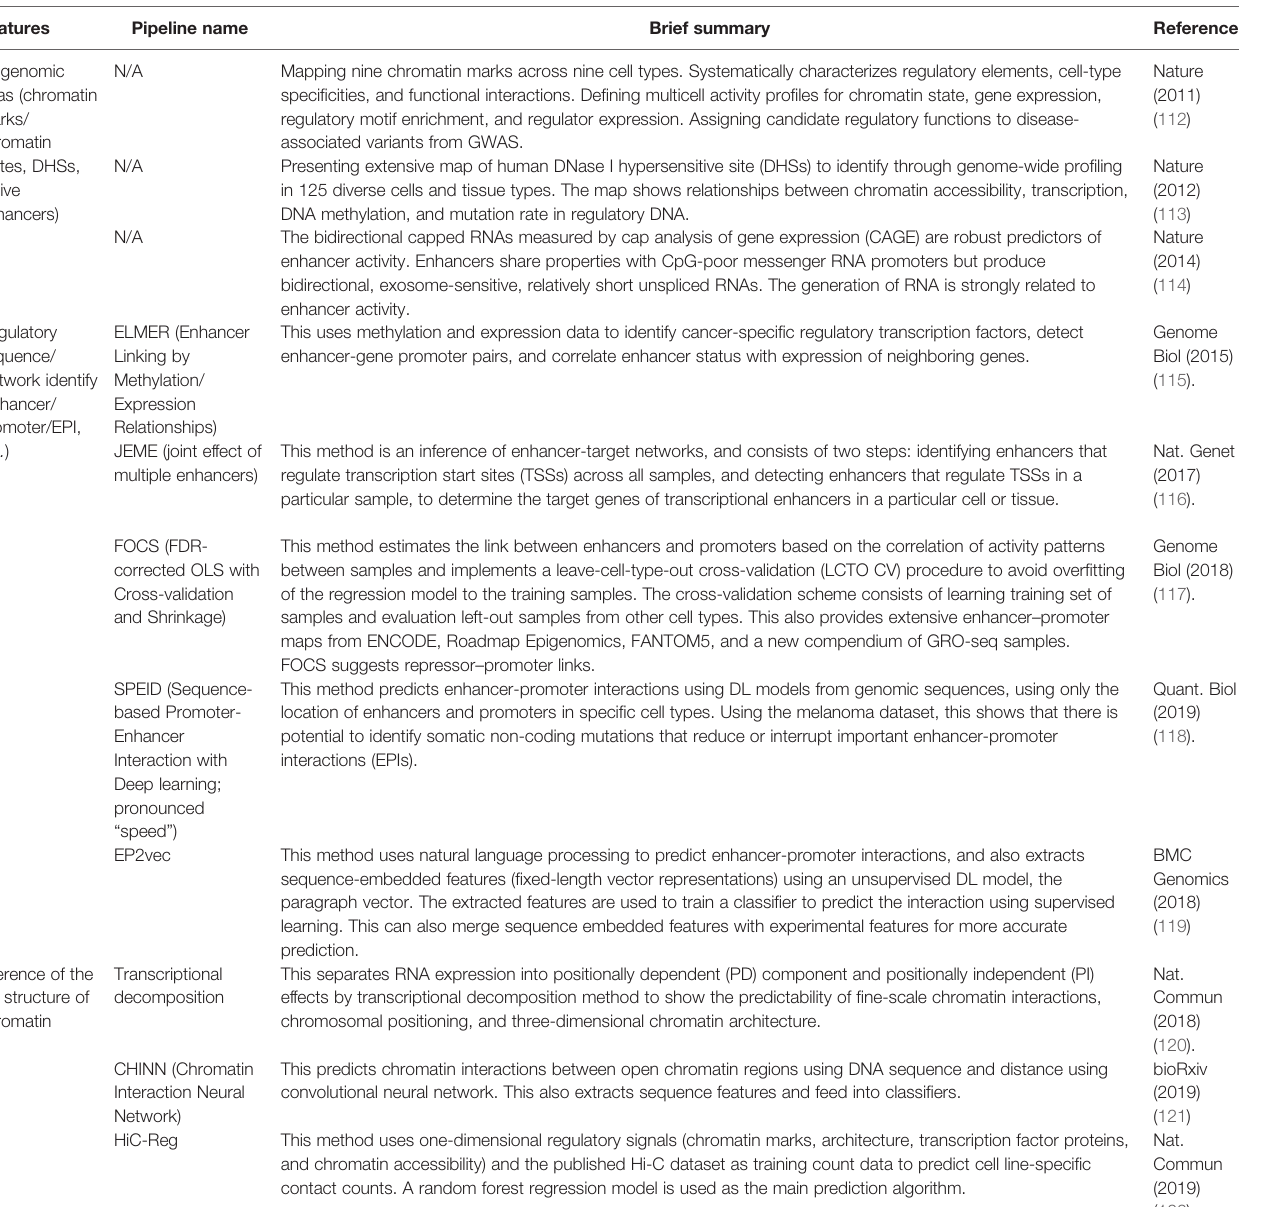
TABLE 2 | Epigenetic analysis typically focusing on regulatory